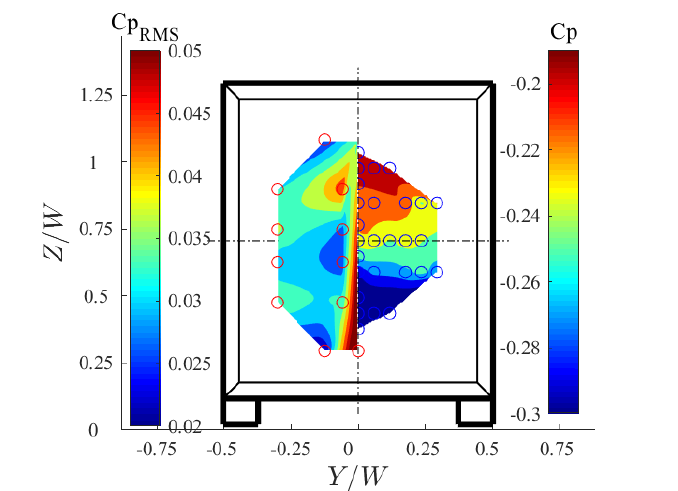
Figure 9. Static pressure (right) and RMS pressure (left) distribution on the rear face for maximum DR % forcing, V lat / V ∞ = 1.4 and V low / V ∞ = 1.2. The location of the actual measurement points is schematically represented using blue and red circles for the static pressure and fluctuating pressure, respectively. The contour representation is obtained by interpolating the measurements on a structured